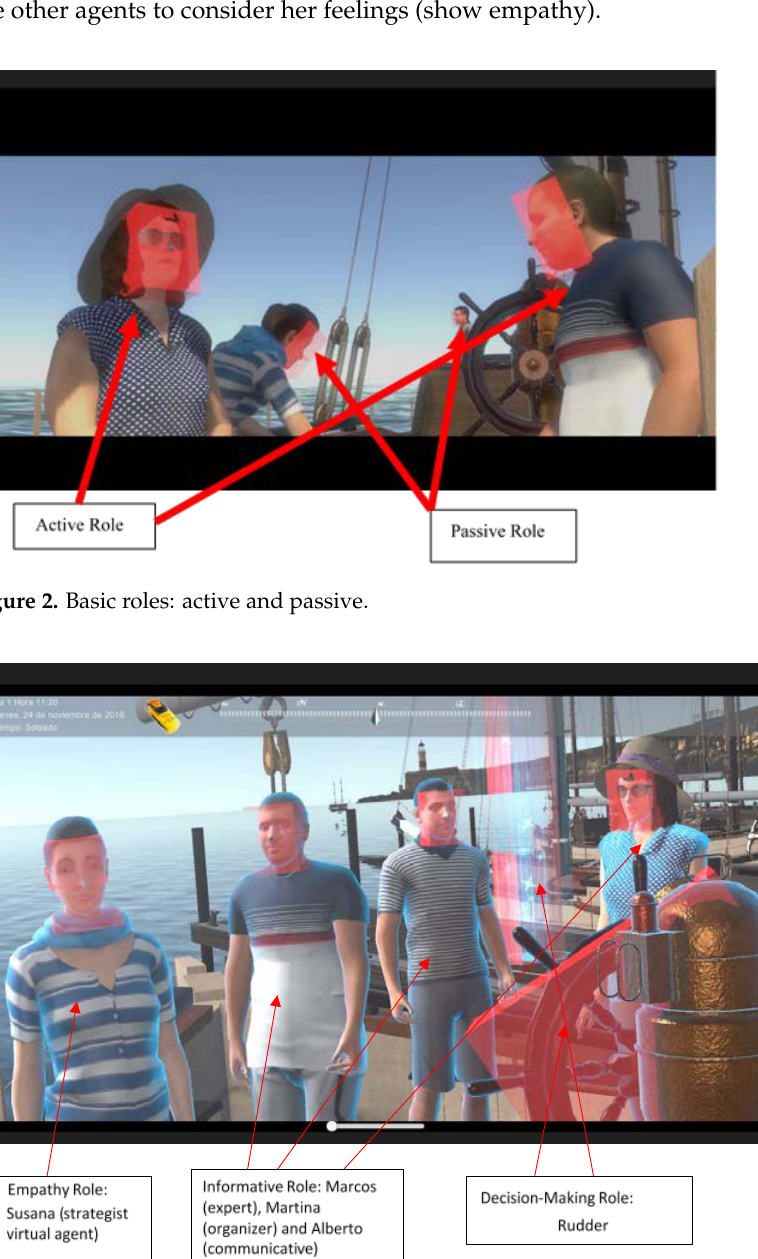
Figure 3 . Example of behavioral roles . Figure 3. Example of behavioral